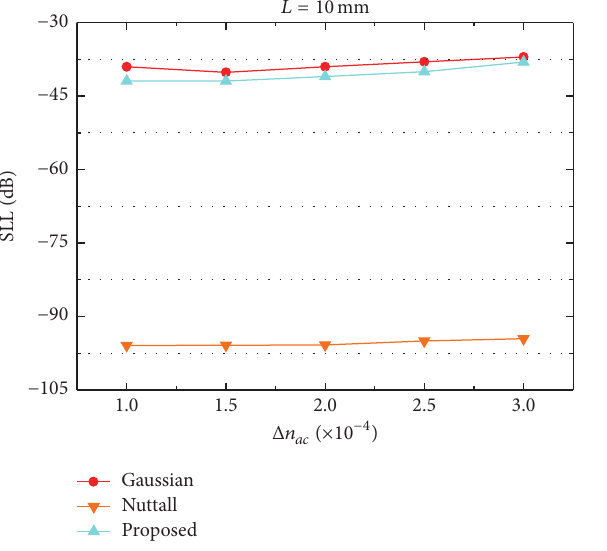
Figure 6: Side lobe level versus refractive index.